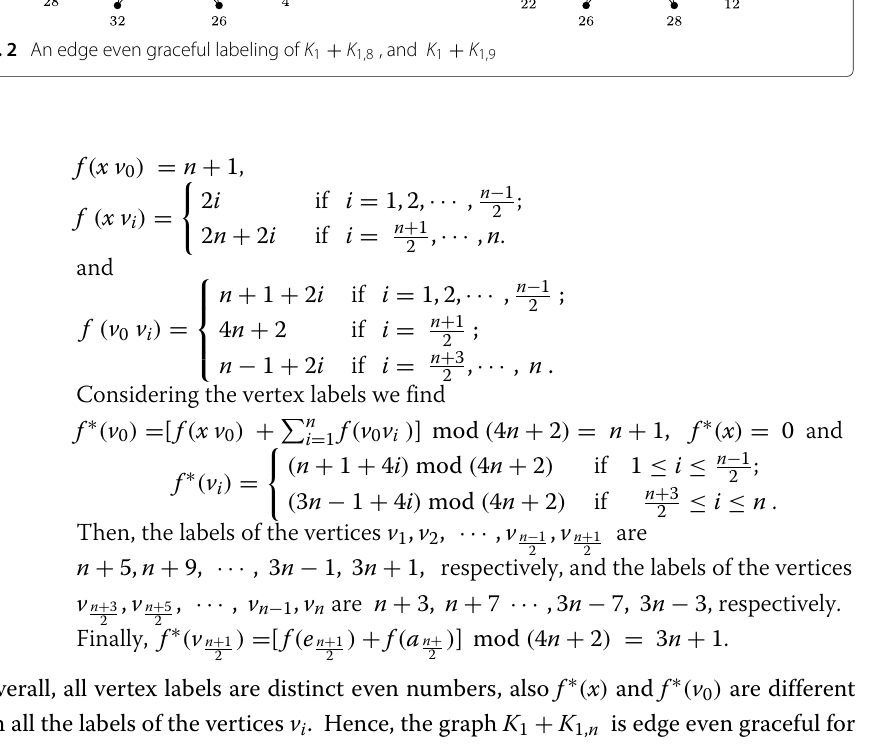
Illustration: In Fig. 2, we present an edge even graceful labeling of the graphs K 1 + K 1,8 and K 1 + K